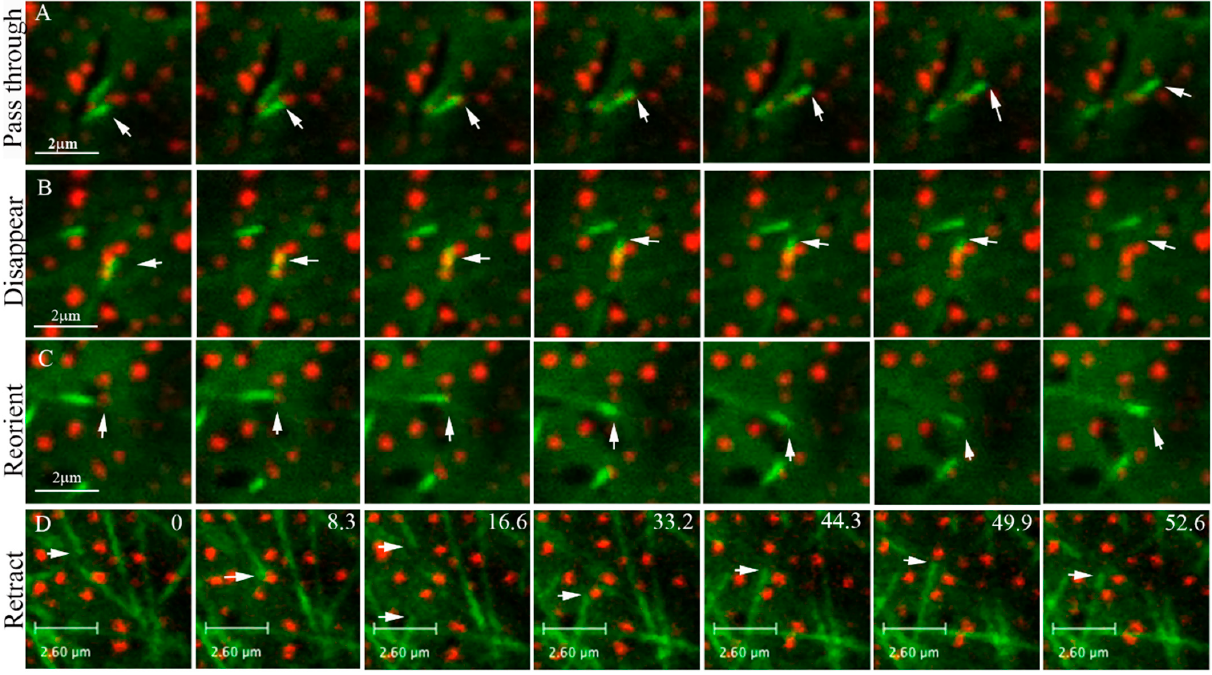
Figure 4. The four scenarios of collisions between MTs and ATM1 IQ-tail clusters. Seven frames, 1 s apart, in ( A – C ) (corresponding to Movie S5), several seconds apart as depicted by numbers in ( D ) (corresponding to Movie S7), show the following: ( A ) a MT passing through a spot, ( B ) a MT overlapping a spot, pausing and then disappearing; ( C ) a MT colliding with a spot and changing direction; ( D ) two MTs retracting after collision.